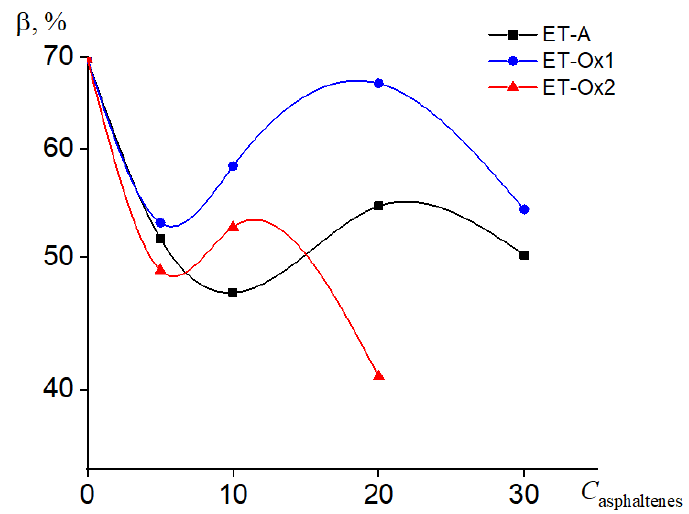
Figure 8. Concentration dependence of the degree of crystallinity of composites based on paraffin containing asphaltenes of various natures.